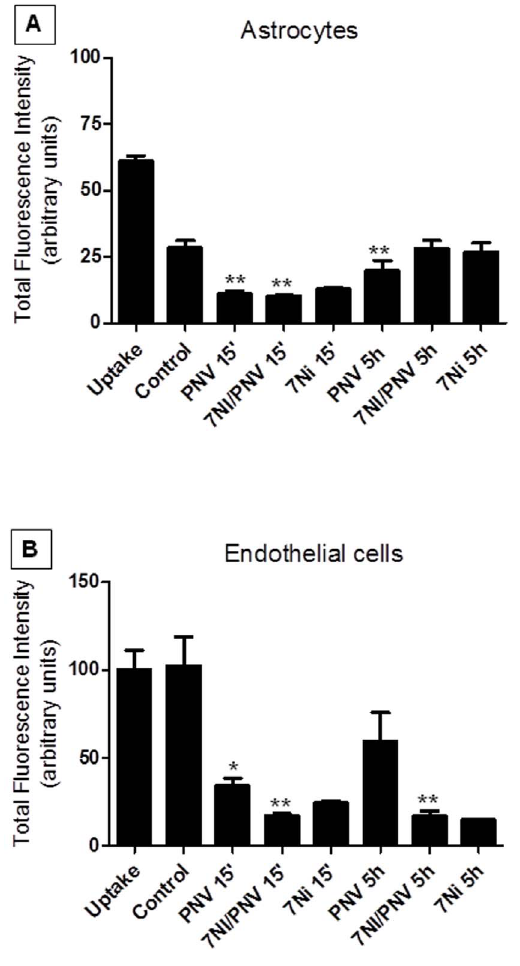
Figure 1. MRP1 activity in astrocytes (A) and endothelial cells HUVEC (B). The activity of MRP1 was assessed by flow cytometry through the fluorescein substrate. The values correspond to the percentage of fluorescence intensity into the cells of the Uptake sample, the maximum fluorescence obtained, and were expressed in Relative Fluorescence Units. In astrocytes, PNV induced immediate (15 min after exposure) decrease in the cellular fluorescence, indicating that MRP1 efflux activity was improved, compared with control; 5 h following envenoming, cells maintained MRP1 activity, although it was not as intense as at 15 min. 7NI + PNV treatment (for 15 min) also induced MRP1 activity in astrocytes, however this treatment for 5 h stopped efflux activity. 7NI per se (both at 15 min or 5 h) did not induce efflux activity. In endothelial cells, PNV induced a decrease in fluorescence at 15 min time-point, but not at 5 h. 7NI + PNV induced more significant MRP1 activity both at 15 min and 5 h in endothelial cells. 7NI treatment per se (used as a control of 7NI/PNV) showed no change in the MRP1 activity relative to 7NI/PNV. The values correspond to the values of three independent experiments. *p , 0.05, **p , 0.01, ***p , 0.001, compared to control cells. Data was analyzed by one-way ANOVA, followed by the Tukey-Kramer